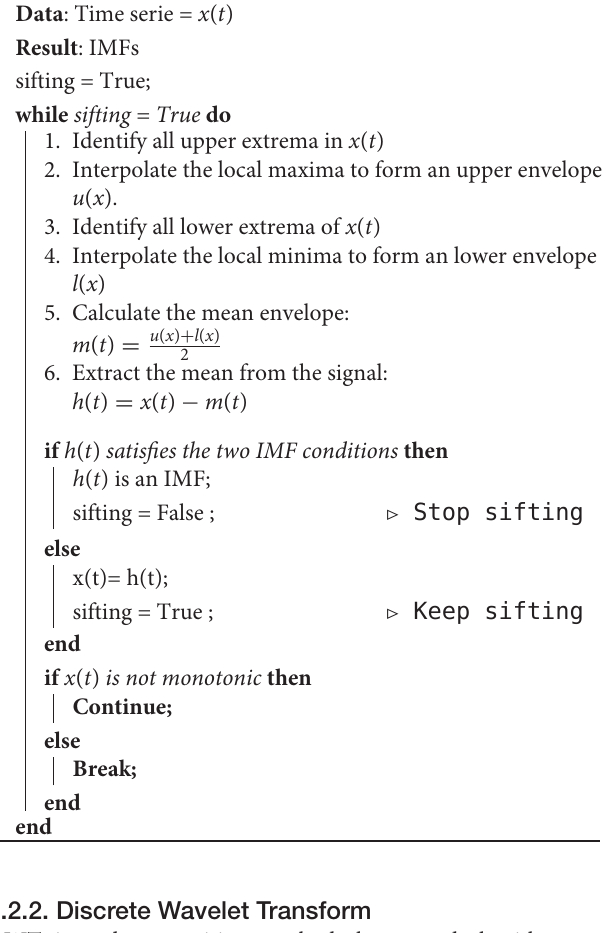
Algorithm 1: The sifting process for a signal x ( t